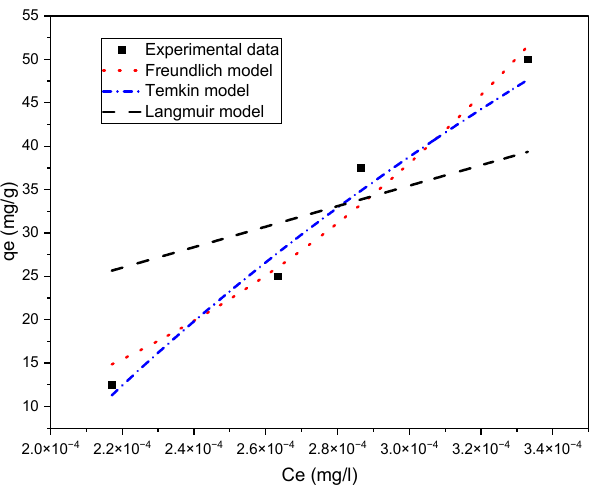
Figure 8. Fitting of adsorption isotherms into experimental data for sample